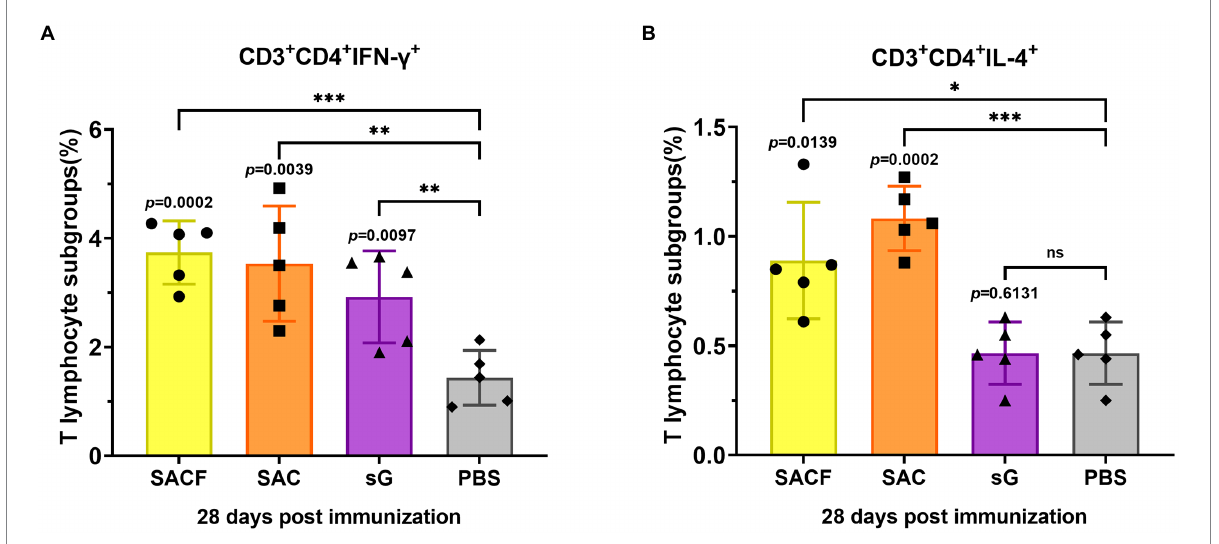
FIGURE 4 Activation of NiV-sG-specific Th1/2 cells after immunization with candidate vaccine at 28 dpi. (A) Data shows the frequency of CD4+ IL-4+ T lymphocytes in CD3 + CD4 + T lymphocytes. (B) Data show the frequency of CD4 + IFN- γ + T lymphocytes in CD3 + CD4 + T lymphocytes. The spleen lymphocytes were obtained after the sacrifice of C57BL/6 mice. Five dots represent five biological replicates. Error bars represent standard deviation from the mean of five replicate values (* p < 0.05, ** p < 0.01, *** p < 0.001, **** p < 0.0001). The Student t test was used to analyze significant differences between the